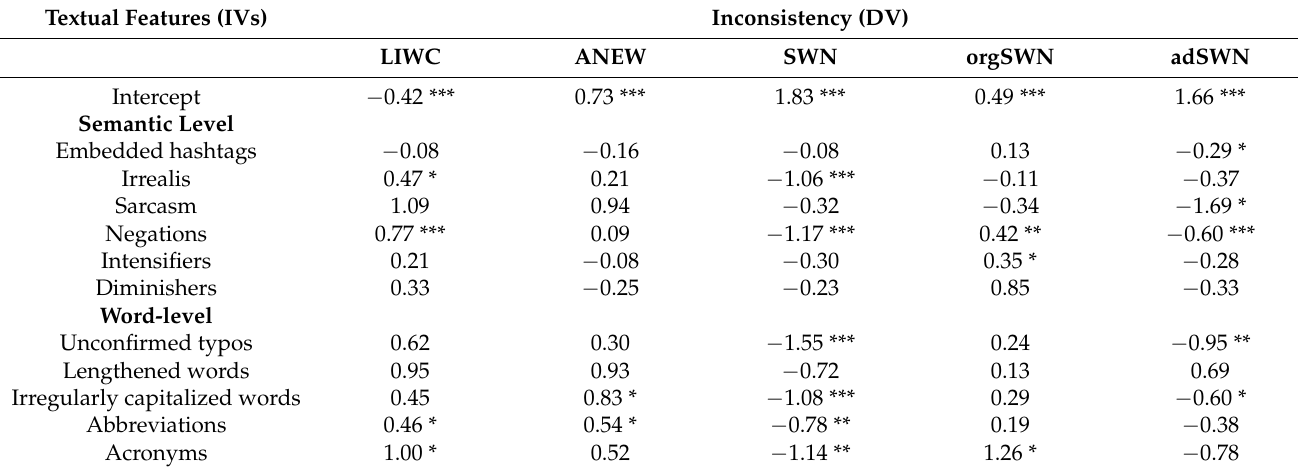
Table 4. The results of binary logistic regression: influences of textual features on